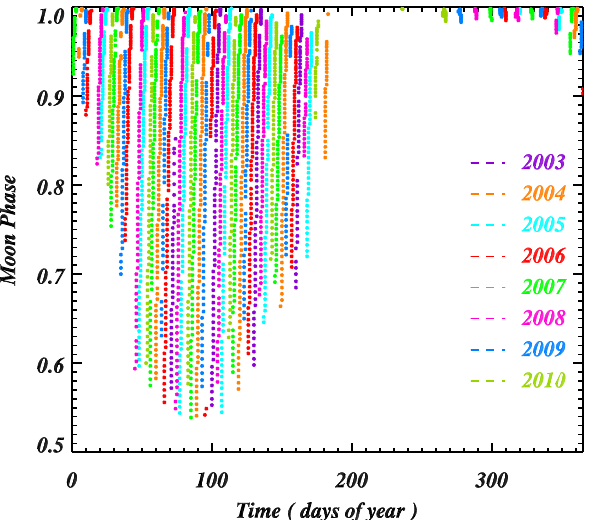
Fig. 4. SCIAMACHY lunar occultation moon phase distribution for the years 2003–2010; the observed moon phase values vary around